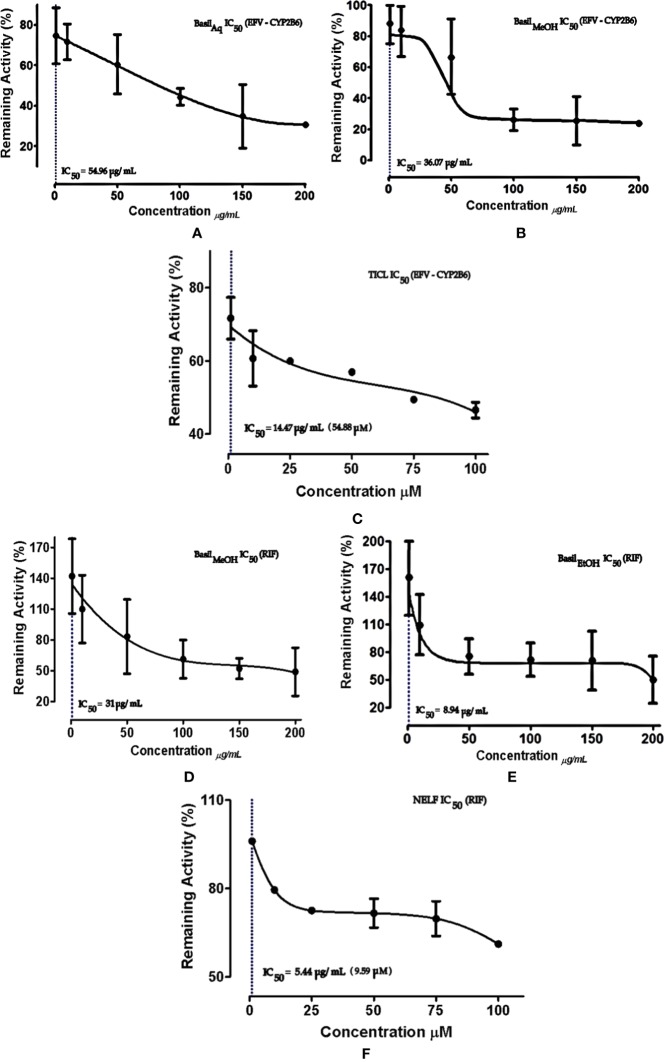
Dose-response curves of basil extracts (with IC50s) for (A) aqueous extract (54.96 μg/ml), (B) methanolic extract (36.07 μg/ml), and positive control (C) ticlopidine (14.47 μg/ml, 54.88 μM) against percentage remaining activity of CYP2B6 with efavirenz as the substrate. Figures (D) methanolic extract (31 μg/ml), (E) ethanolic extract (8.94 μg/ml), and positive control (F) nelfinavir (5.44 μg/ml, 9.59 μM) represent the IC50 dose-response curves of basil extracts against percentage remaining activity of rifampicin metabolism. The IC50 is calculated as log(X) against Y.